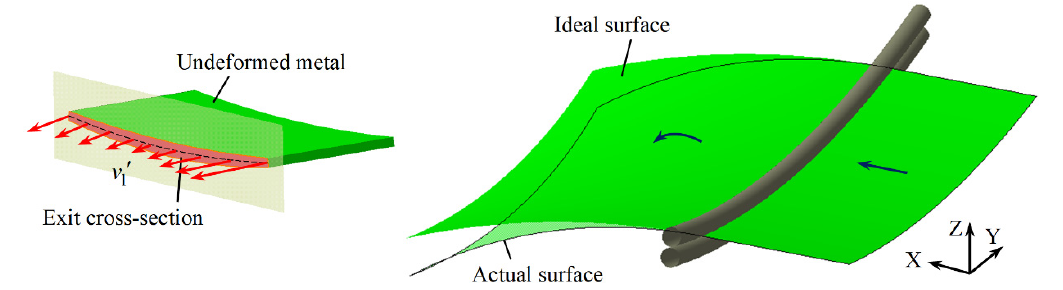
Figure 8. Negative Gaussian curvature surface formed by CRF.